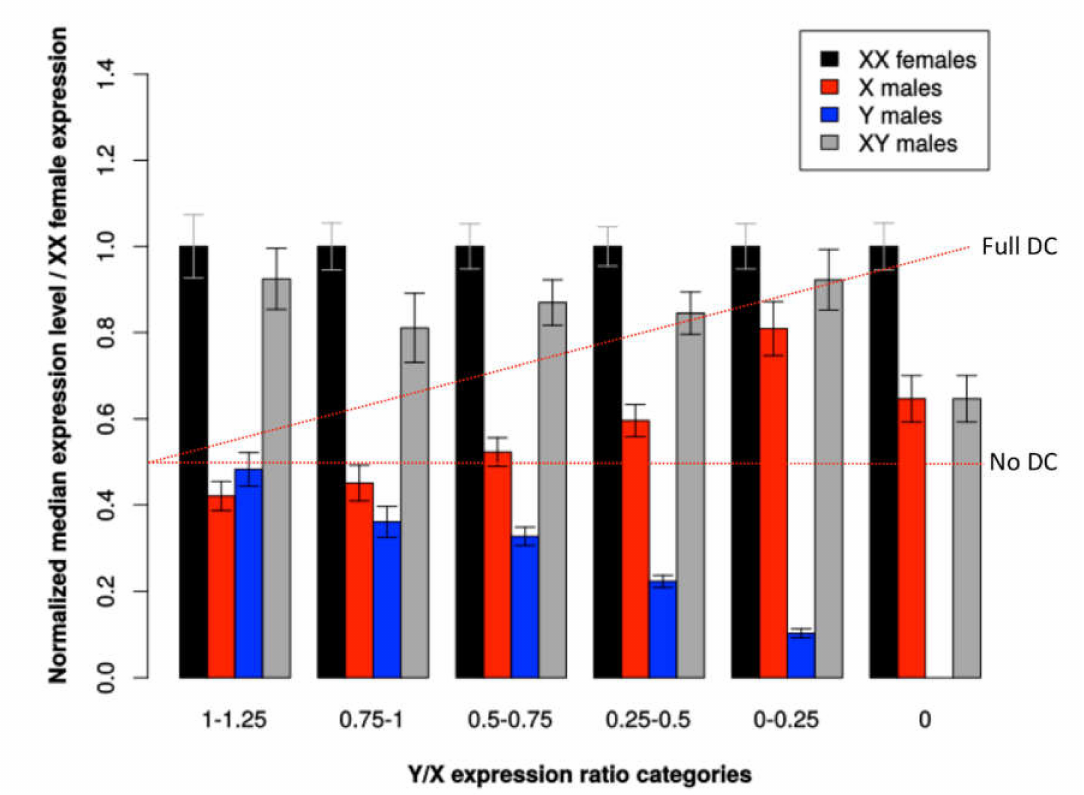
Figure 3. Allele-specific expression of sex-linked genes in both sexes in C. grandis . Expression levels of sex-linked contigs in both sexes are shown for di ff erent Y / X expression ratio categories. Total read numbers were summed at sex-linked SNP locations in each contig and normalized for each individual separately; medians for all contigs and individuals of the same sex were then obtained. XX females, median expression level of both X-linked alleles in females; X males, median expression level of the single X-linked allele in males; Y males, median expression level of the Y-linked allele in males; XY males, median expression level of the X-linked plus Y-linked alleles in males. To compare di ff erent Y / X expression ratio categories, medians were normalized using the XX expression levels in females. Two red lines indicate predictions for X males: full dosage compensation (X males = XX females − Y males) and no dosage compensation (X males = 0.5 XX females). With increasing Y degeneration (measured by the Y / X ratio), Y expression (blue bars) declines. We observed that X males (red bars) does not follow the prediction of no dosage compensation and instead tends to increase with increasing Y degeneration, following the ‘full dosage compensation’ line. The total expression in males (X males + Y males, grey bars) is mostly maintained across the di ff erent categories of Y degeneration and is comparable to the expression in females (black bars). These patterns suggest dosage compensation is taking place in C. grandis . The case of the X-hemizygous genes (Y / X = 0) is discussed in the text. Sample sizes are: 0, 168; 0–0.25, 207; 0.25–0.5, 261; 0.5–0.75, 243; 0.75–1, 148; 1–1.25, 108. Error bars indicate 95% confidence intervals of the